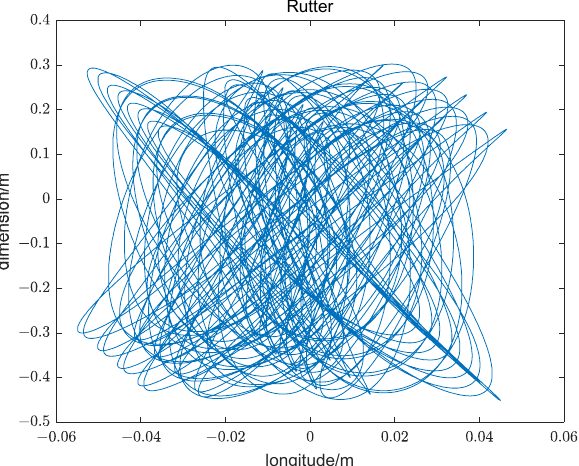
Table 2. Swaying parameter settings.